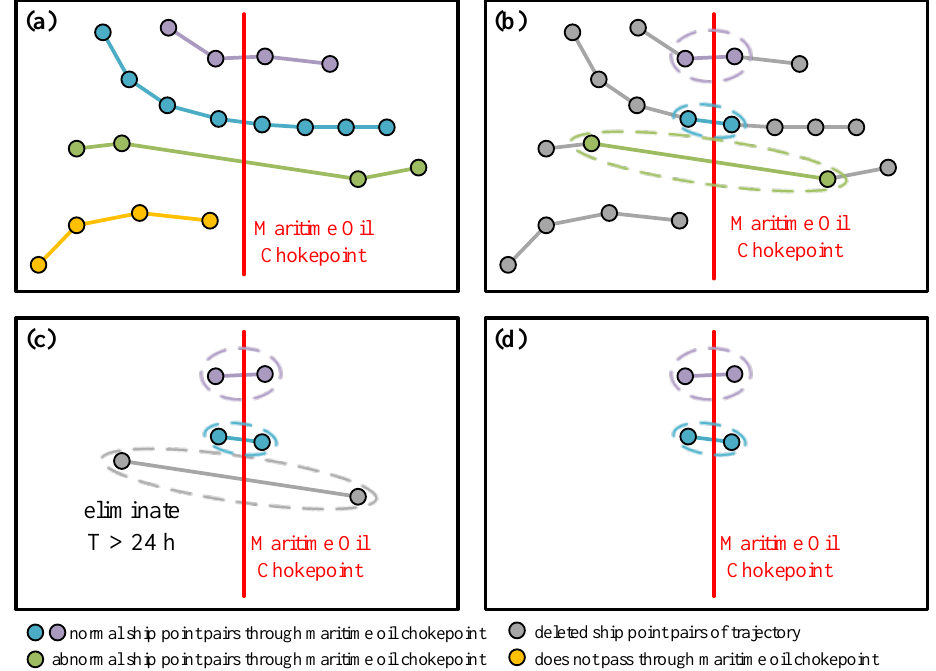
Figure 4. The extraction of ship point pairs. ( a ) Original ship trajectories; ( b ) The process of extracting the ship point pairs; ( c ) The process of eliminating abnormal ship point pairs; ( d ) The extracting result of ship point